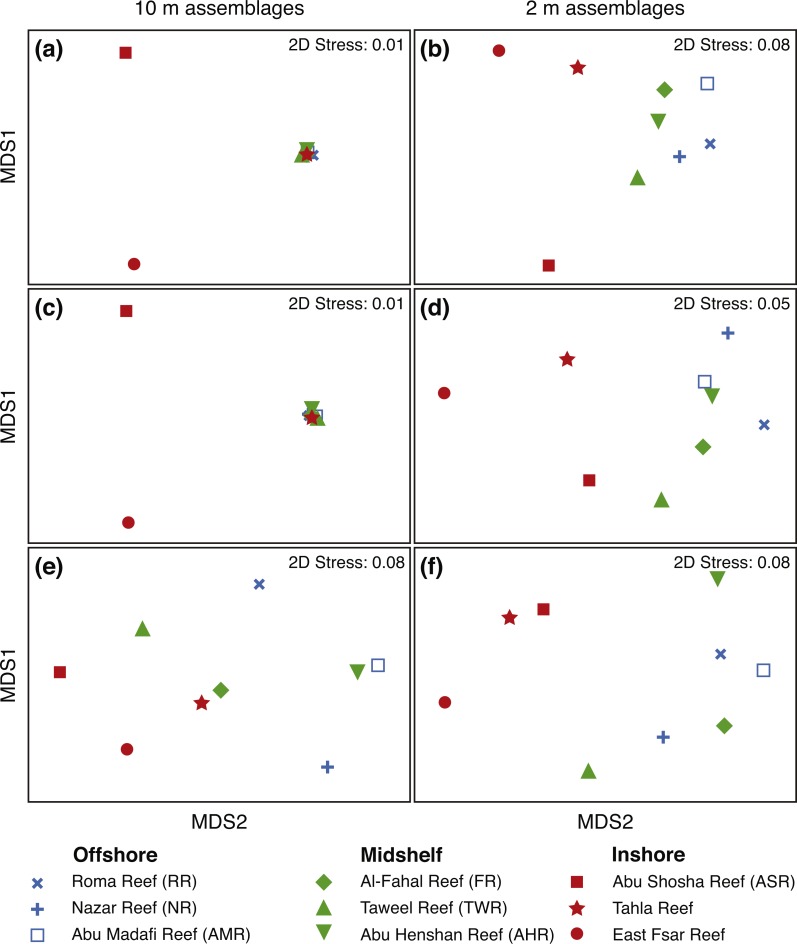
Fish and benthic assemblage NMDS plots.Non-metric multi-dimensional scaling (NMDS) plots from Bray-Curtis resemblance matrices based on log (x + 1)-transformed reef averages for fish biomass (A and B), fish densities (C and D), and benthic cover (E and F); the left column of panels shows 10 m assemblages, while the right column shows 2 m assemblages. X-axes represent NMDS1 and y-axes represent NMDS2. Reef name abbreviations are shown in the inset key next to their representative symbols, and the nine reefs are color-coded according to distance from shore as shown by the key. The 2D stress values are shown in each plot. All data were averaged across the relevant replicates for each reef. Fish and benthic data were collected together on the same transects (six per reef in total) from the central Saudi Arabian Red Sea.